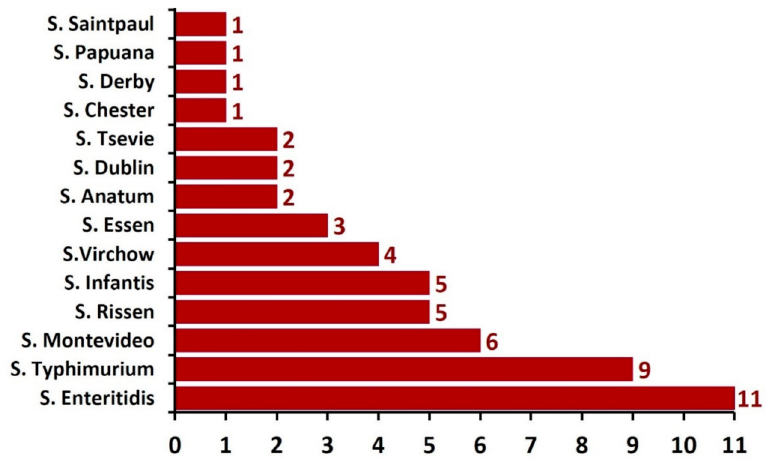
Figure 1. Distribution of the identified Salmonella serovars (n = 53) isolated from buffalo meat